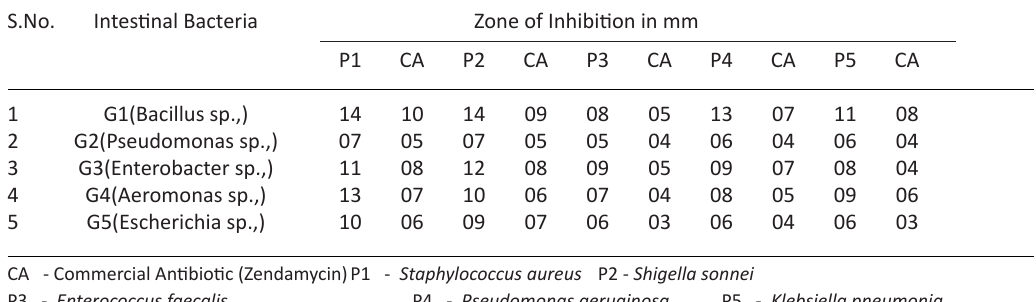
Table 6. Enumeration of Intestinal bacteria of Blue Gourami S.No